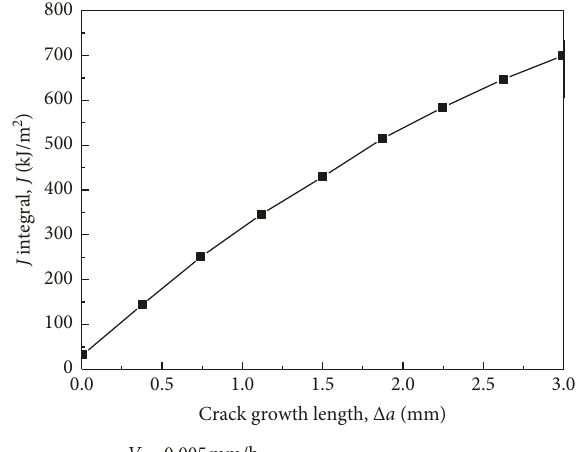
Figure 14: The relationship between J -integral and crack growth